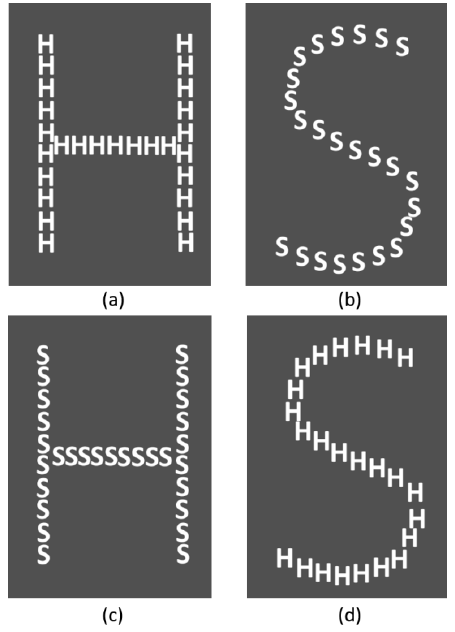
Figure 3. The four types of stimuli used in the CRTT. ( a , b ) Congruent stimuli. ( c , d ) Incongruent stimuli.